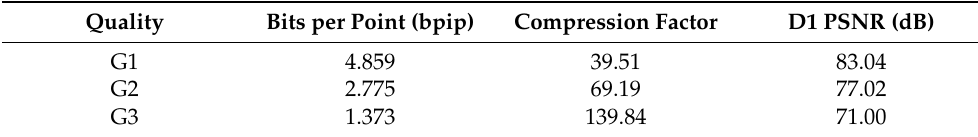
Table 2. Average bitrates, compression factors and point-to-point distances (D1 PSNR) of compressed point